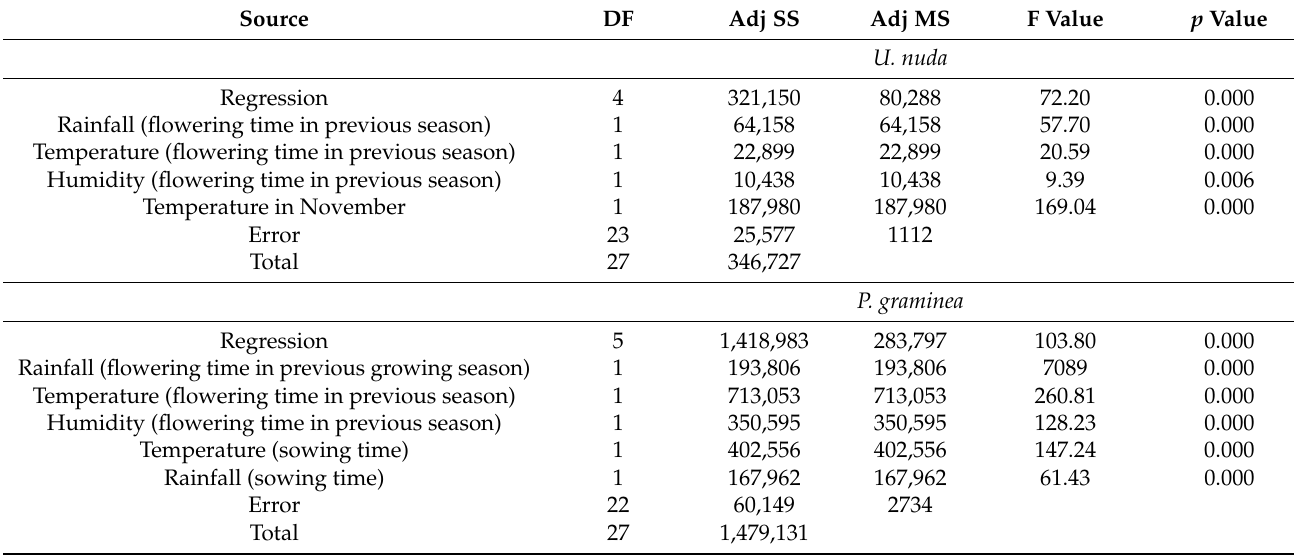
Table 3. Regression analysis of the most influential factors on the occurrence of U. nuda and